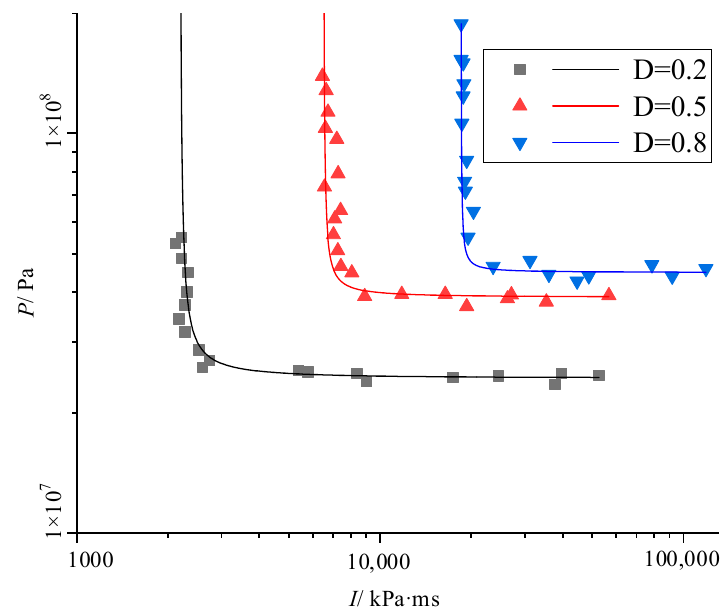
Figure 8. P-I curve of roadway wall under geostress loading. Figure 8. P - I curve of roadway wall under geostress